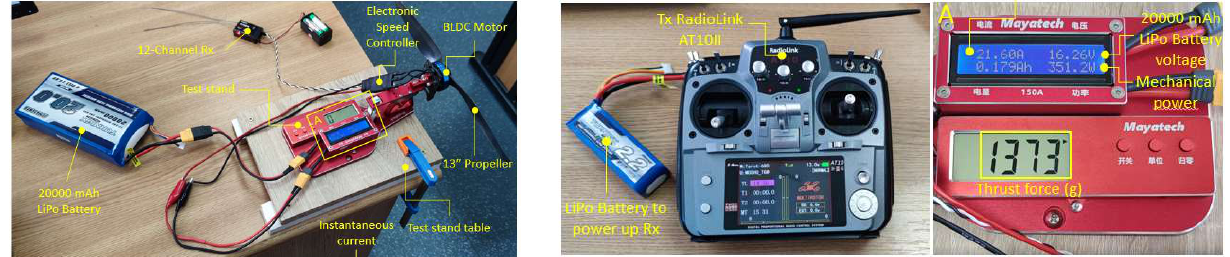
Figure 12. Propulsion system efficiency test stand configurations.